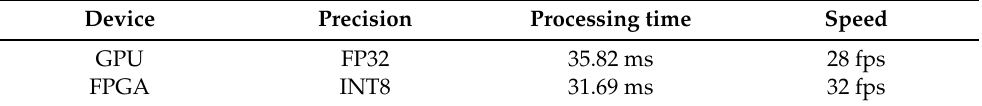
Table 7. Run-time Performance of the Proposed Approach on SemanticKITTI